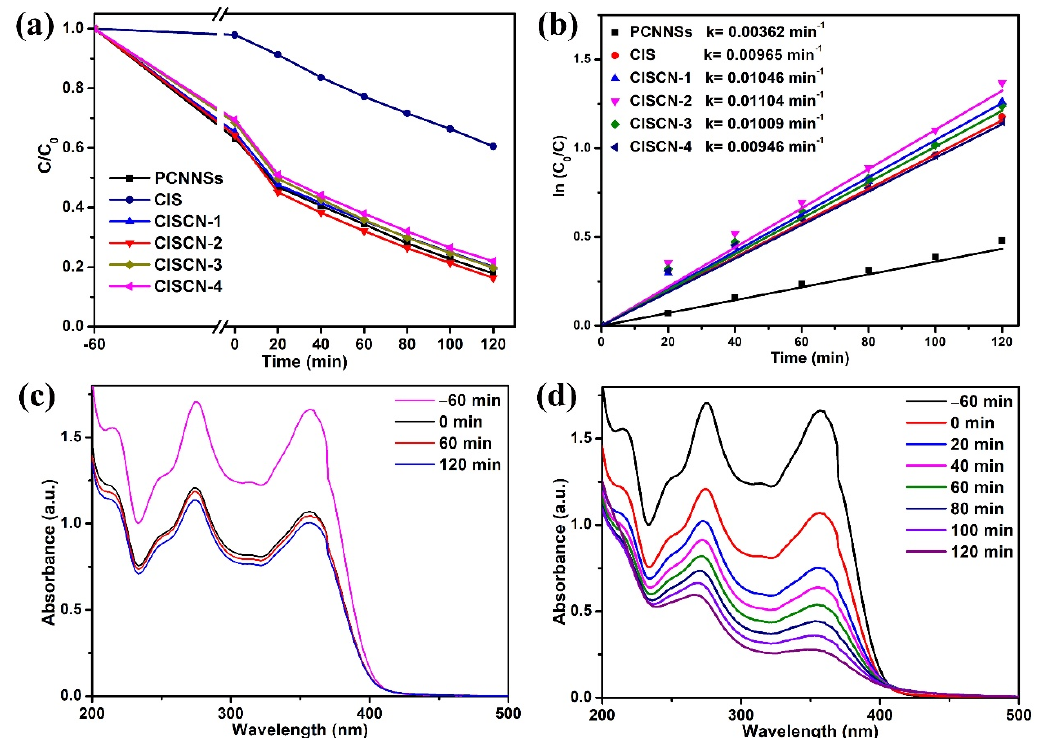
Figure 5. ( a ) Photocatalytic performance of various samples toward TCH photodegradation under visible light illumination; ( b ) the kinetic curves fitted by pseudo-first-order equations over different samples; ( c ) UV-vis spectra of TCH adsorbed by CISCN-2 for different time periods; and ( d ) UV-vis spectra of TCH at different periods of photocatalytic process over CISCN-2. Table 1. Degradation efficiency (DE) of TCH over previous reports and CISCN-2 in this work. Sample TC (mg/L) Dosage (g/L) t (min) Light Source DE (%)